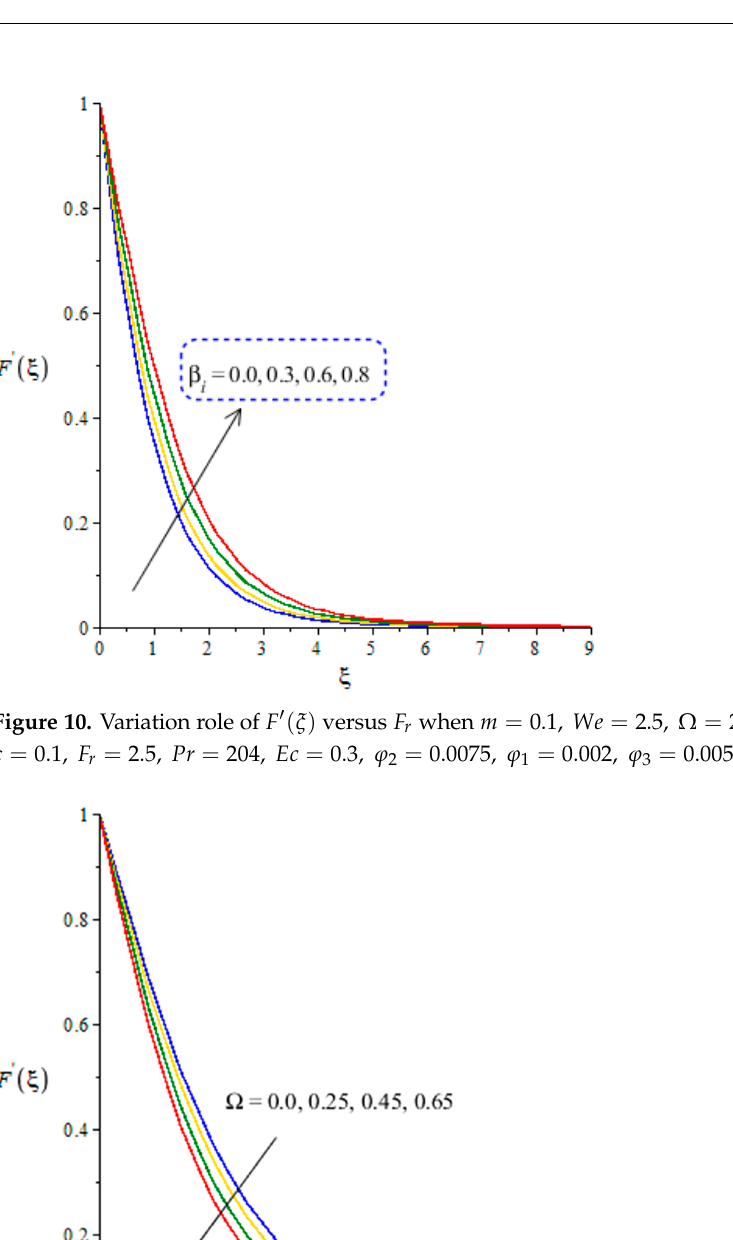
Figure 9. Variation role of −𝐺(𝜉) versus 𝐹 (cid:3045) when 𝑚 = 0.3, 𝑊𝑒 = 5, Ω = 3.0, 𝑀 (cid:2870) = 0.01,𝛽 (cid:3032) =